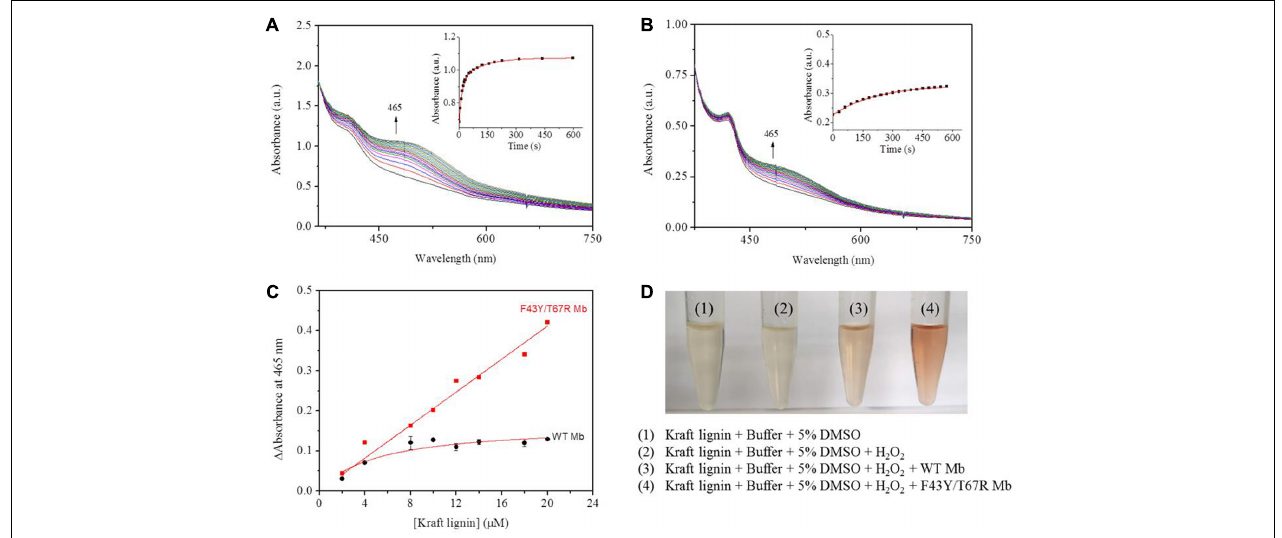
FIGURE 7 | Kinetic studies of Kraft lignin (14 µ M) in the presence of H 2 O 2 (2.0 mM) catalyzed by 2 µ M F43Y/T67R Mb (A) or WT Mb (B) . Time-dependent changes of the absorbance at 465 nm were shown as insets, and were fitted to the single-exponential decay function. (C) The changes of absorbance at 465 nm after 10 min with different concentrations of Kraft lignin, as catalyzed by F43Y/T67R Mb and WT Mb. The plots were fitted to the linear and Michaelis-Menten equations, respectively. (D) Visual appearance of Kraft lignin (14 µ M) oxidation in the absence (1) and presence (2–4) of H 2 O 2 (2.0 mM), WT Mb (3) and F43Y/T67R Mb (4) (2 µ M) for 10